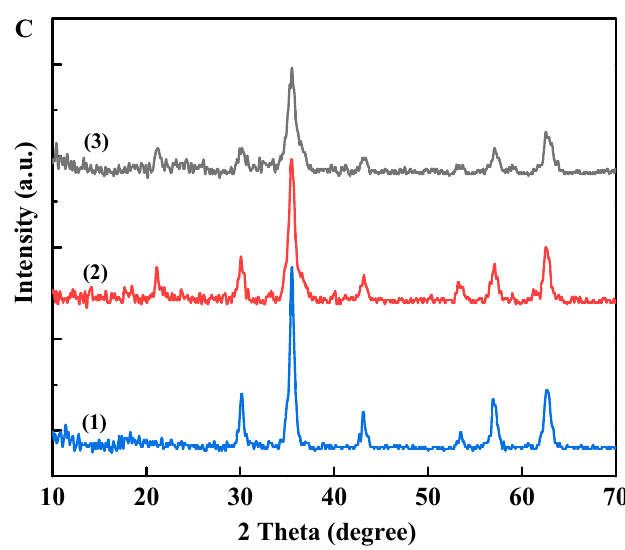
Figure 3. XPS spectra ( A ), FT-IR spectra ( B ), and XRD patterns ( C ) of Fe 3 O 4 ( 1 ), Fe 3 O 4 @PDA ( 2 ) and Fe 3 O 4 @PDA@TLL ( 3 ).